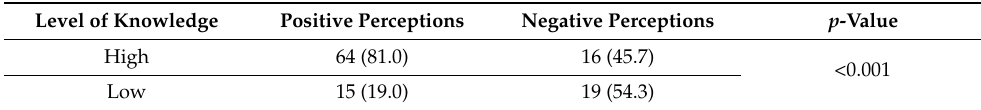
Table 5. Association between knowledge and perceptions.